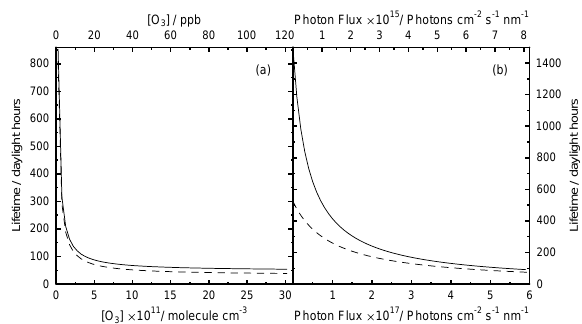
Fig. 10. Atmospheric lifetime, τ , of a 0.4µm 5-nitroguaiacol parti- cle as a function of [O 3 ] (a) and photon flux (b) determined using γ of the 1:1 by mass PP/NG substrate. Solid and dashed lines rep- resent derived lifetime under VIS and UV irradiation, respectively. Dashed line in (b) refers to top